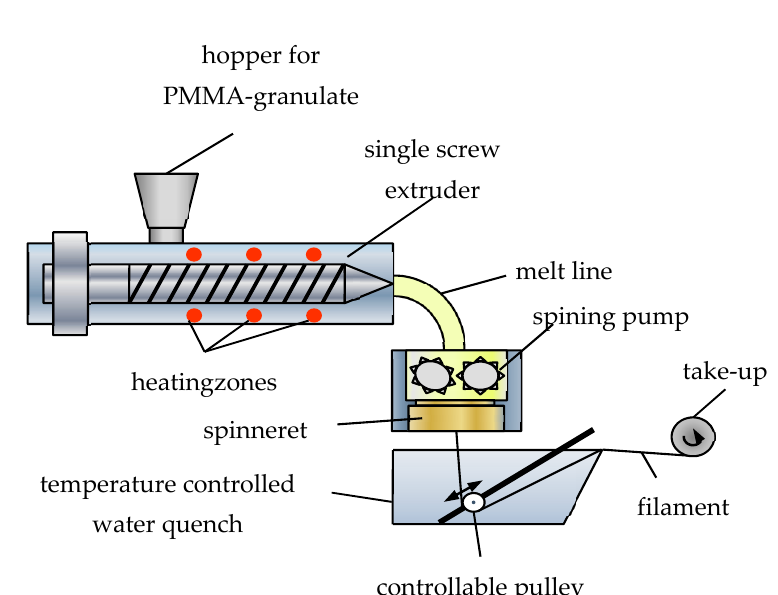
Figure 2. Schematic of the melt-spinning process based with subsequent rapid cooling in a water quench [16]. The still hot polymer filament is subjected to a rapid cooling in a water quench right below the spinning nozzle. The rapid cooling results in an inhomogeneous cooling speed over the fiber cross-section.